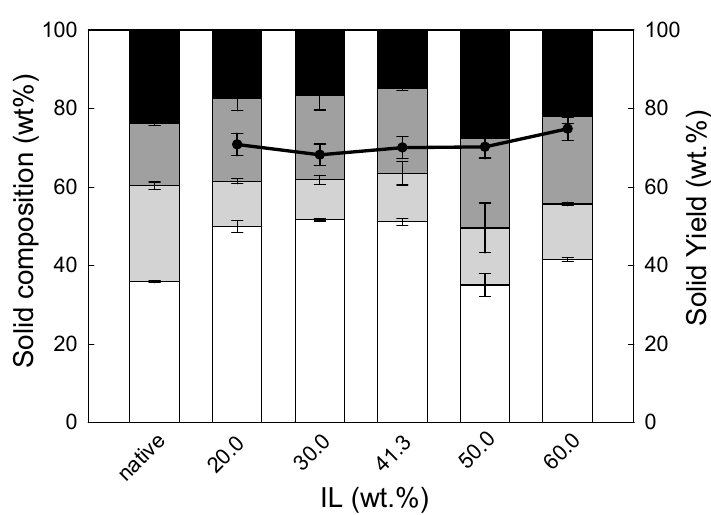
Figure 2. The solid phase composition (white bar–cellulose; light grey bar–hemicellulose; dark grey bar–Klason lignin; black bar–others) of wheat straw pre-treatment at 140 °C and 90 min with [emim][HSO 4 ] at various % IL. The solid line represents the solid yield (wt.%) of pre-treated solids recovered after pre-treatment.